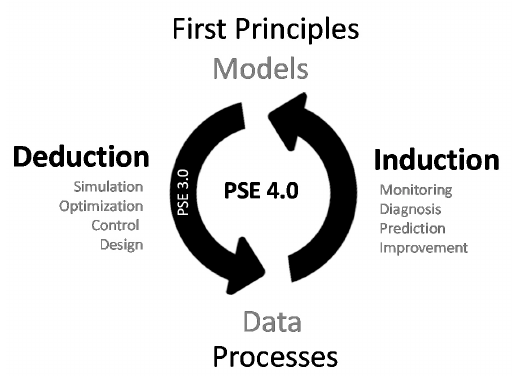
Figure 1. The complementary deductive and inductive branches of Process Systems Engineering (PSE) 4.0.